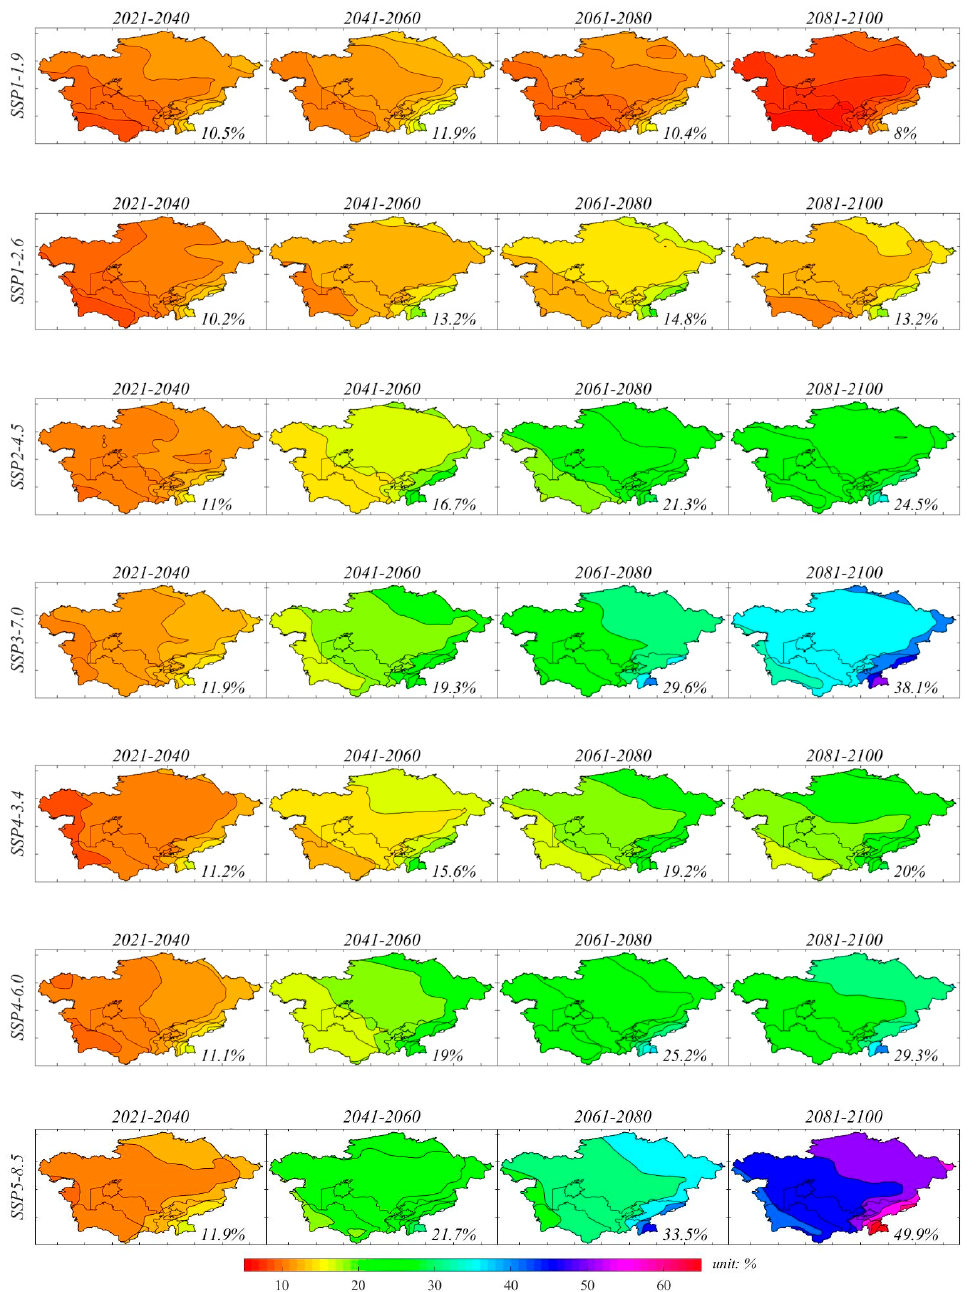
Figure 6. Spatial distribution of the change in TCWV amount in four 20-year periods (2021–2040, 2041–2060, 2061–2080, 2081–2100) under 7 future scenarios (SSP1-1.9, SSP1-2.6, SSP2-4.5, SSP3-7.0, SSP4-3.4, SSP4-6.0, SSP5-8.5), relative to the baseline period 1986–2005. The areal average TCWV growth rate for Central Asia is shown in the lower right corner of each